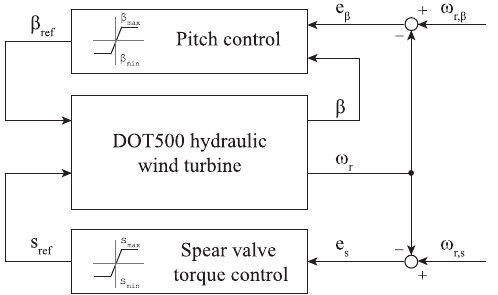
Figure 11. Schematic diagram of the DOT500 control strategy. When the control error e is negative, the controllers saturate at their minimum or maximum setting. In the near-rated operating region, the rotor speed is actively regulated to ω r ,s by generating the spear position control signal s ref , influencing the fluid pressure and the system torque. When the spear valve is at its rated minimum posi- tion, the gain-scheduled pitch controller generates a pitch angle set point β ref to regulate the rotor speed at its nominal value ω r ,β